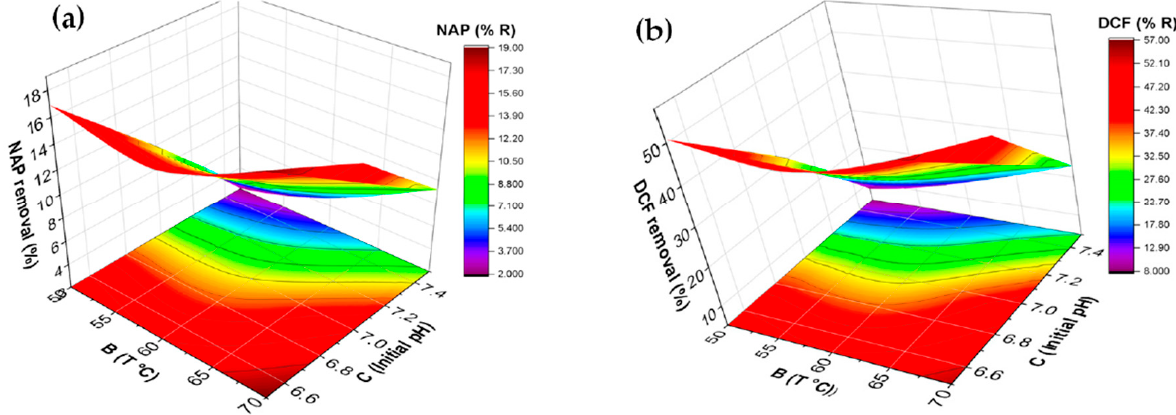
Fig 5 Figure 5. Combined effect of temperature and pH on the removal of ( a ) NAP and ( b ) DCF. Reaction conditions: [NAP] [DCF] 0 = 5.0 mg L − 1 , [catalyst] = 1.0 g L − 1 , and 3 h of reaction